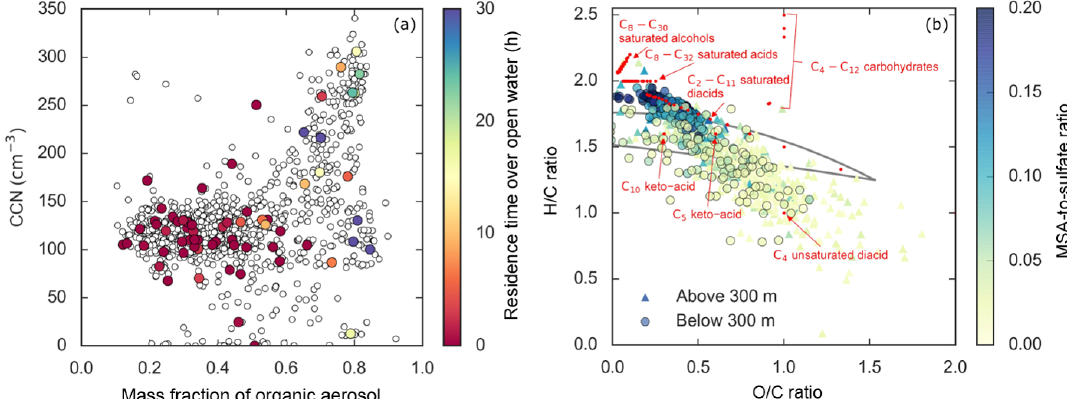
Figure 8. Panel (a) illustrates that the number of CCN (at 0.6% supersaturation) measured by NETCARE in the summertime Arctic in 2014 is related to the organic mass fraction of the particles measured by an aerosol mass spectrometer. Open circles are all the data points. The closed, coloured circles represent the FLEXPART-WRF predicted air mass residence time over open water in the boundary layer prior to the measurement (see Willis et al., 2017, for details). Panel (b) plots the H / C vs. the O / C ratios of submicron aerosol measured during the same summertime 2014 campaign. The circles and triangles are low ( < 300m) and high ( > 300m) altitude points, respectively, and the colour is the MSA-to-sulfate ratio of the aerosol. High ratios indicate large biogenic secondary impact. The convergence of points with high ratios to an H / C ratio close to 2 indicates a composition with substantial hydrocarbon-like character, as indicated in red by the placements for common molecules. Figures from Willis et al. (2017).